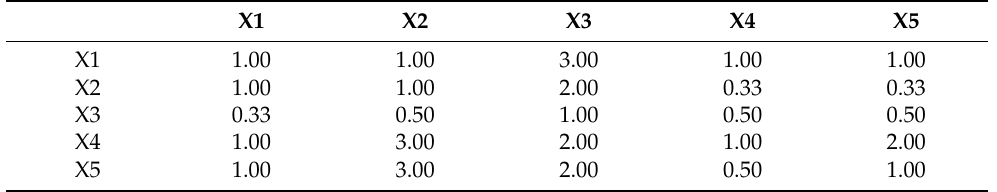
Table 5. The pairwise comparison for main criteria X i .